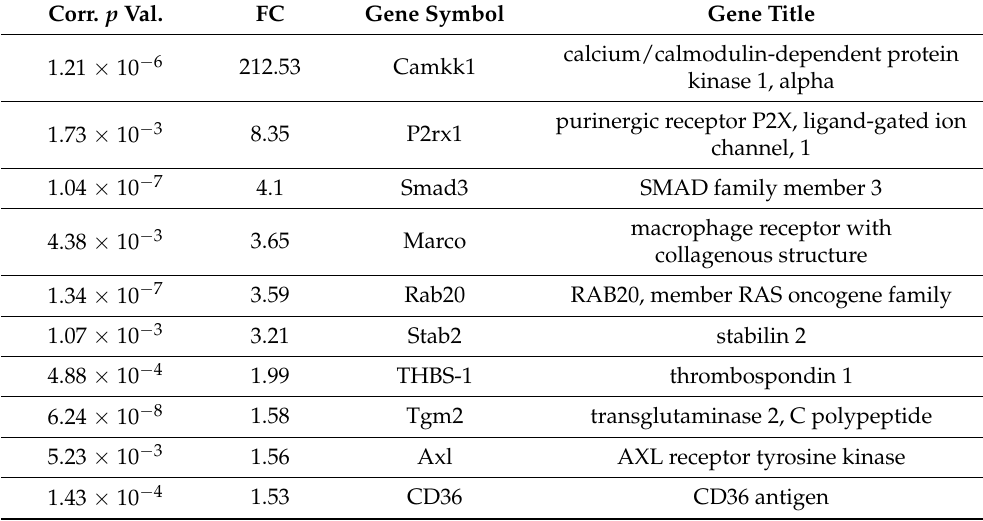
Table 1. List of differentially expressed efferocytosis-related genes between BMDMs treated with DMSO- or 1 µ M DHR during the last 48 h of their differentiation (based on at least 1.5-fold change and corrected p value < 0.05). Corr. p Val. FC Gene Symbol Gene